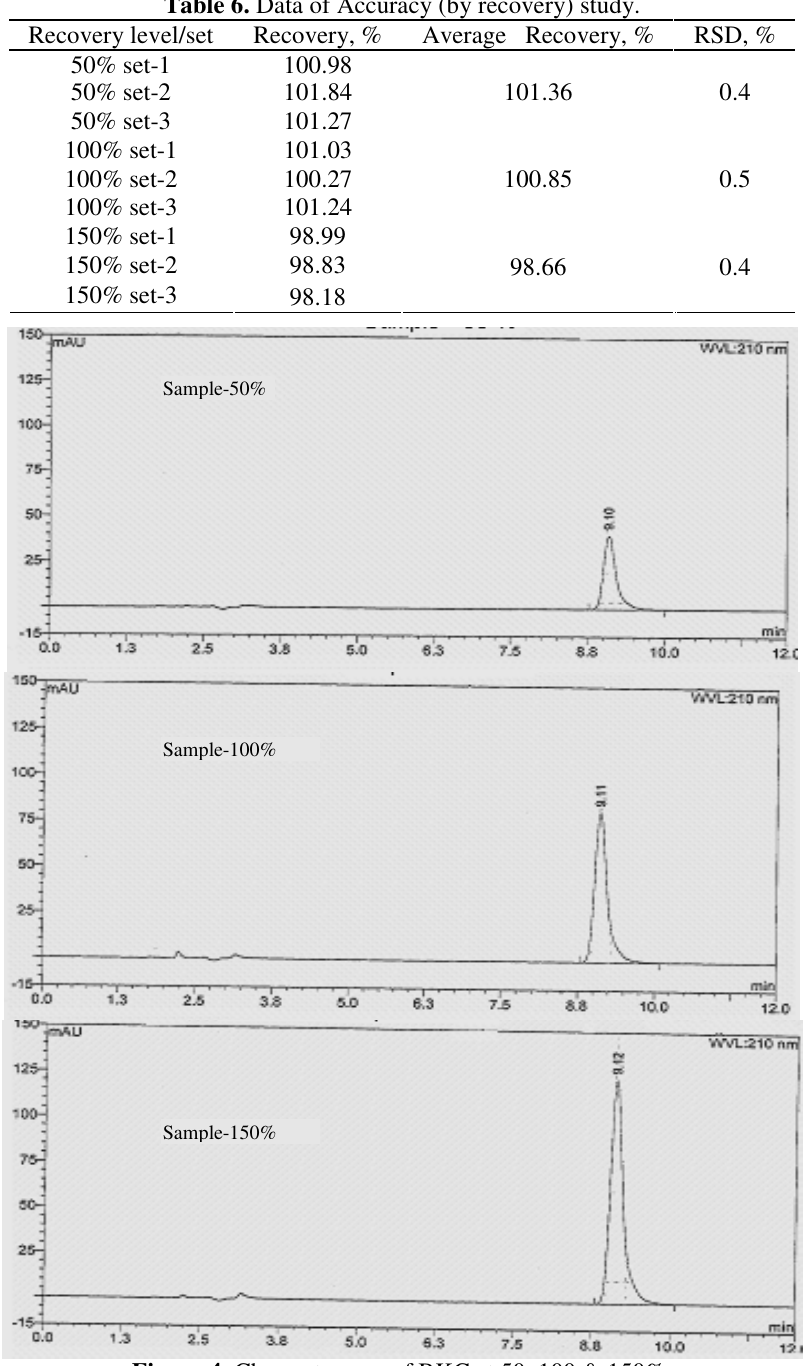
Figure 4. Chromatogram of BKC at 50, 100 &